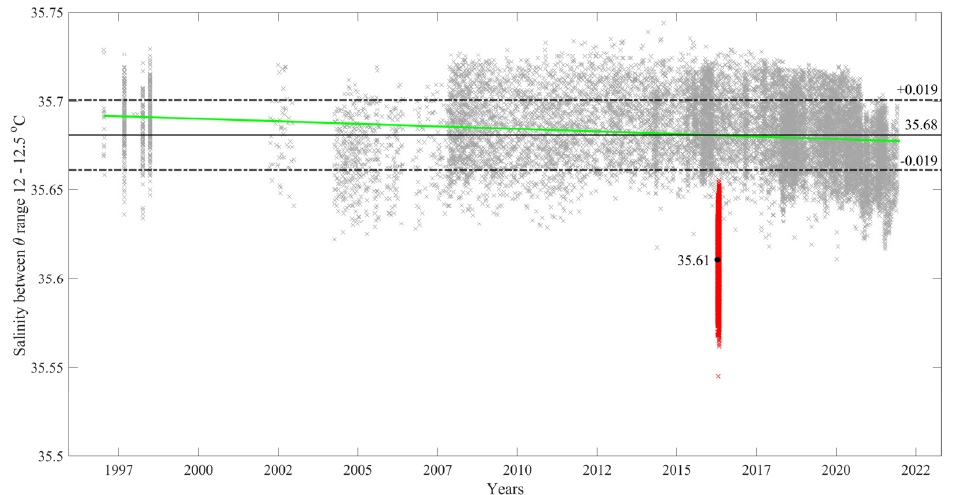
Figure 4. Temporal distribution of salinity between the potential temperature range of 12 ◦ C and 12.5 ◦ C for the historical database (ARGO and CANIGO) with gray dots. Green solid line represents the linear fit calculated for the temporal distribution of salinity of the historical database. The black solid line represents the mean salinity of the historical database and the black dashed lines its standard deviation. The red dots show the salinity obtained by the glider without applying any correction for the potential temperature range of 12 ◦ C and 12.5 ◦ C. The mean salinity of the glider observations is marked with a black dot.